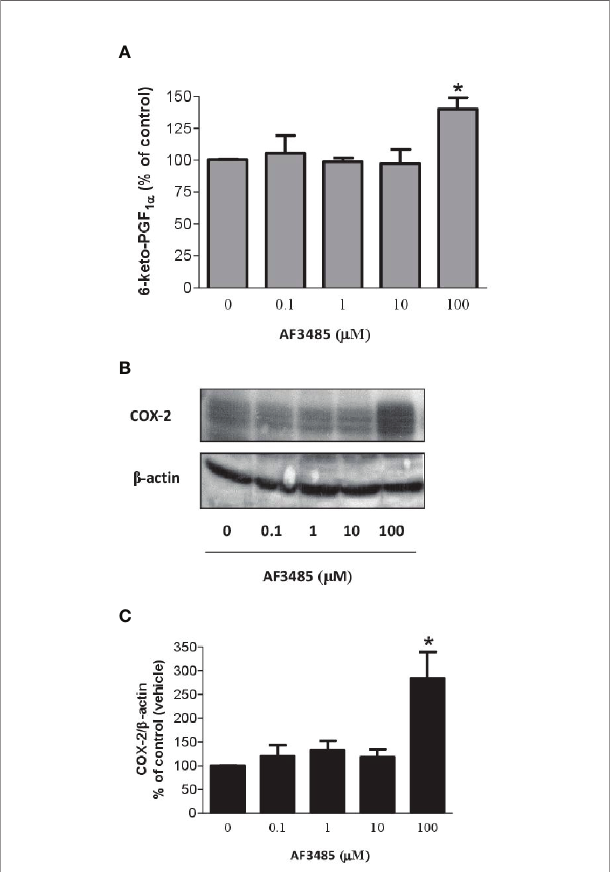
FIGURE 6 | Effects of AF3485 on PGI 2 biosynthesis and COX-2 expression in HUVEC. (A) HUVEC (1x10 6 cells) were treated with increasing concentrations of AF3485 for 24 h and the conditioned medium was collected to assess the nonenzymatic hydrolysis product of PGI 2 , i.e., 6-keto- PGF 1 a ;values are shown as mean ± SEM, n = 4; *P < 0.05 versus vehicle (DMSO). (B) Western blot analysis of COX-2 expression in HUVEC; b -actin levels were used as protein loading control; the blot is representative of three different experiments. (C) In HUVEC treated with AF3485, densitometric analysis of COX-2 bands normalized to b -actin was performed; results are reported as % of control (DMSO vehicle) (mean ± SEM, n = 3); *P < 0.05 versus control (DMSO) (Student's ( Figure 7B ). GW9662 (50 µM) almost wholly abolished the increase in 6-keto-PGF 1 a caused by AF3485 ( Figure 7B ). This effect was associated with a signi fi cant (P < 0.05) reduction in the COX-2 expression that had been induced by AF3485 100 µM ( Figures 7C, D ).